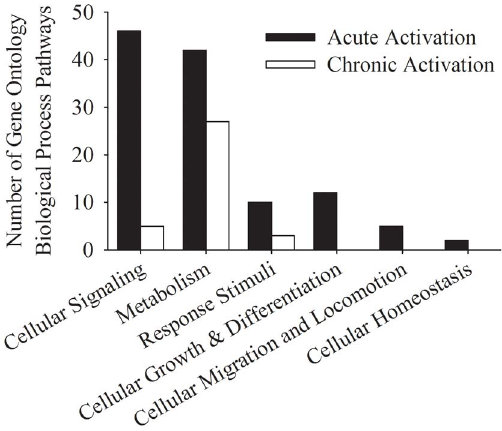
Fig. 2. Gene Ontology(GO) Biological Process pathways upregulated by gene set enrichment analysis(GSEA) compared to non-stimulated limb. 117 pathways, primarily consisting of intra- and inter- cellular signaling pathways were upregulated 3-hours after a single session of exercise using electrical muscle stimulation (Acute Soleus Stimulation). 35 pathways, primarily consisting of metabolic pathways, were upregulated in subjects that trained . 7 years using electrical muscle stimulation (Chronic Soleus